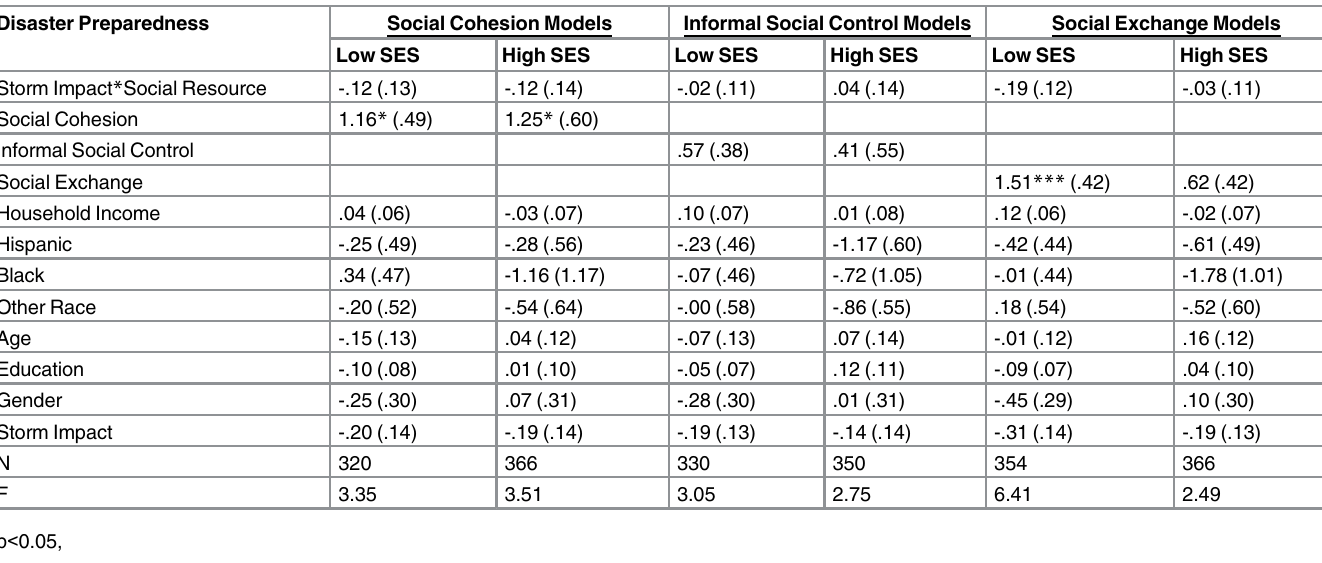
Table 6. Social resources and their associations with beliefs about disaster preparedness for low and high SES